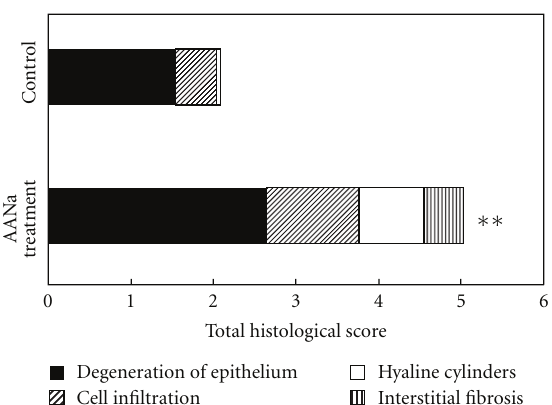
Figure 4: Tubulointerstitial histological scores of rabbits after